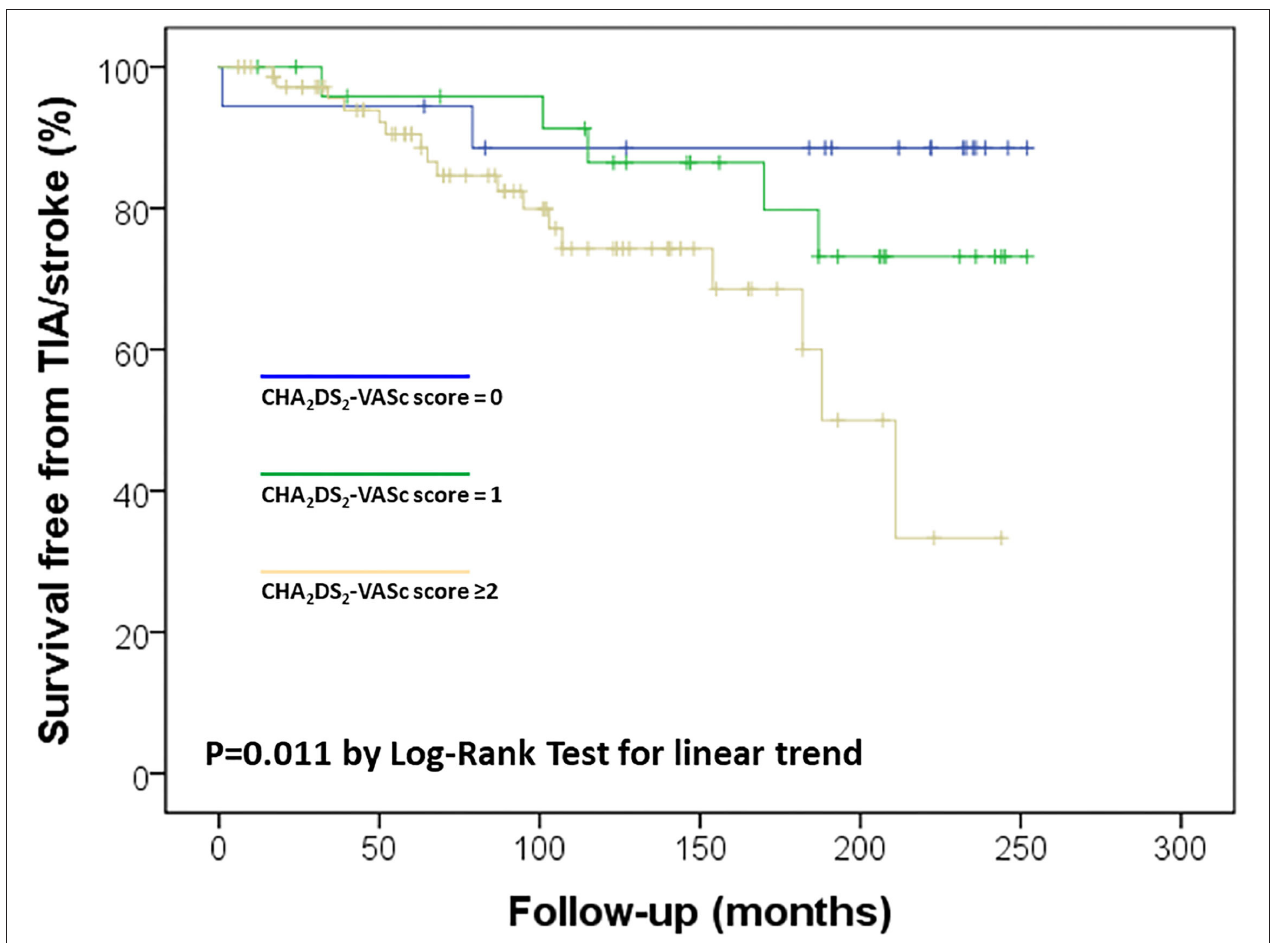
FIGURE 2 | Kaplan-Meier survival curves for ischemic stroke/transient ischemic attack (TIA) in the study sample according to CHA 2 DS 2 -VASc